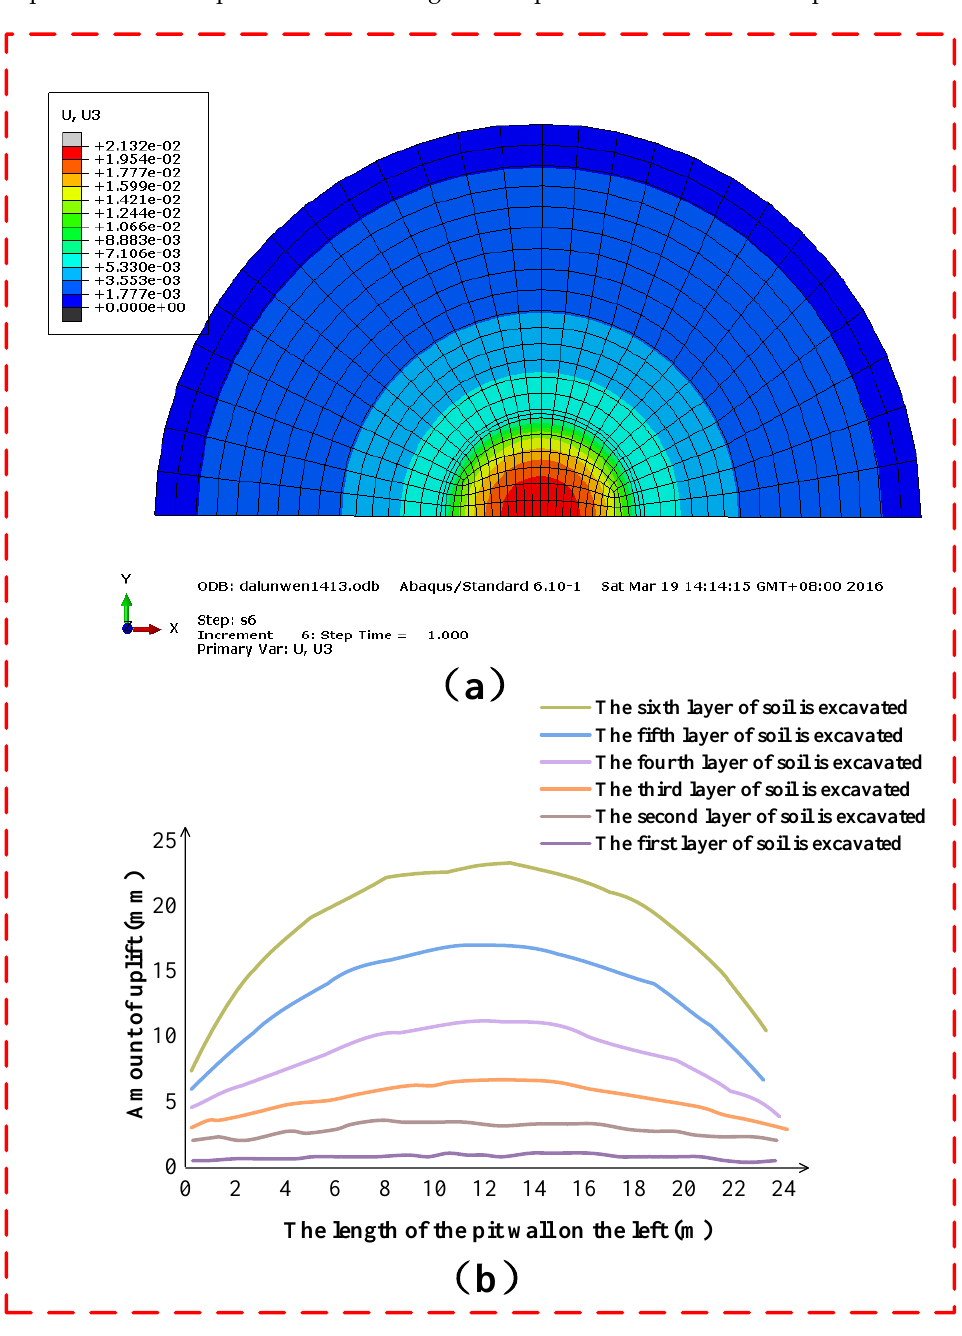
Figure 12. The bottom of the pit: ( a ) soil profile displacement cloud; ( b ) pit floor vertical displace- ment diagram.